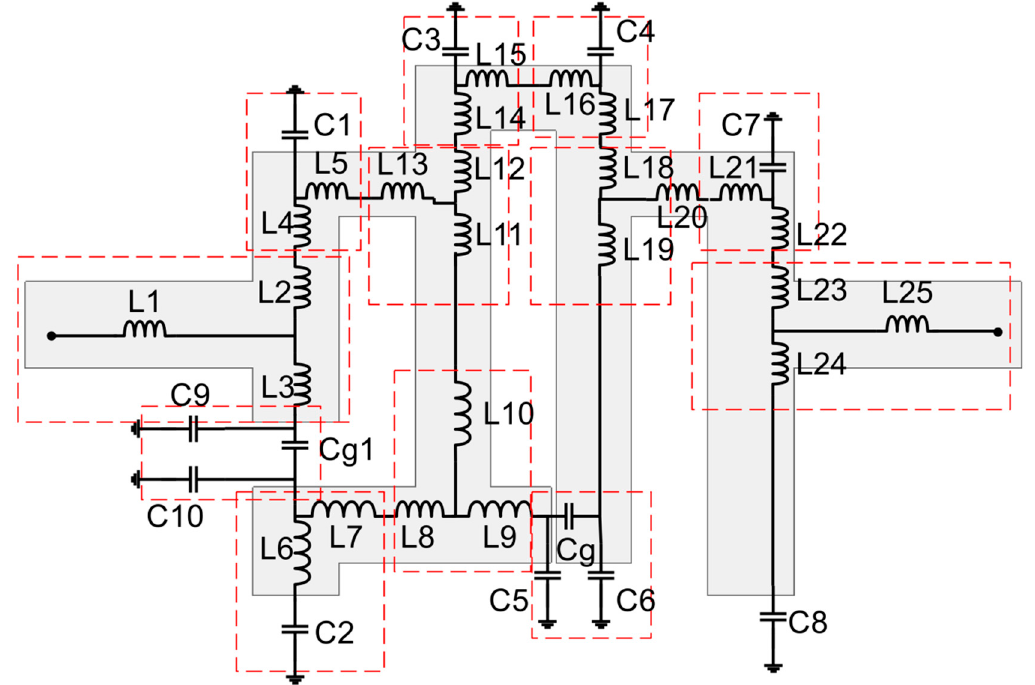
Figure 10. Equivalent circuit when PIN diode OFF (mode 2).